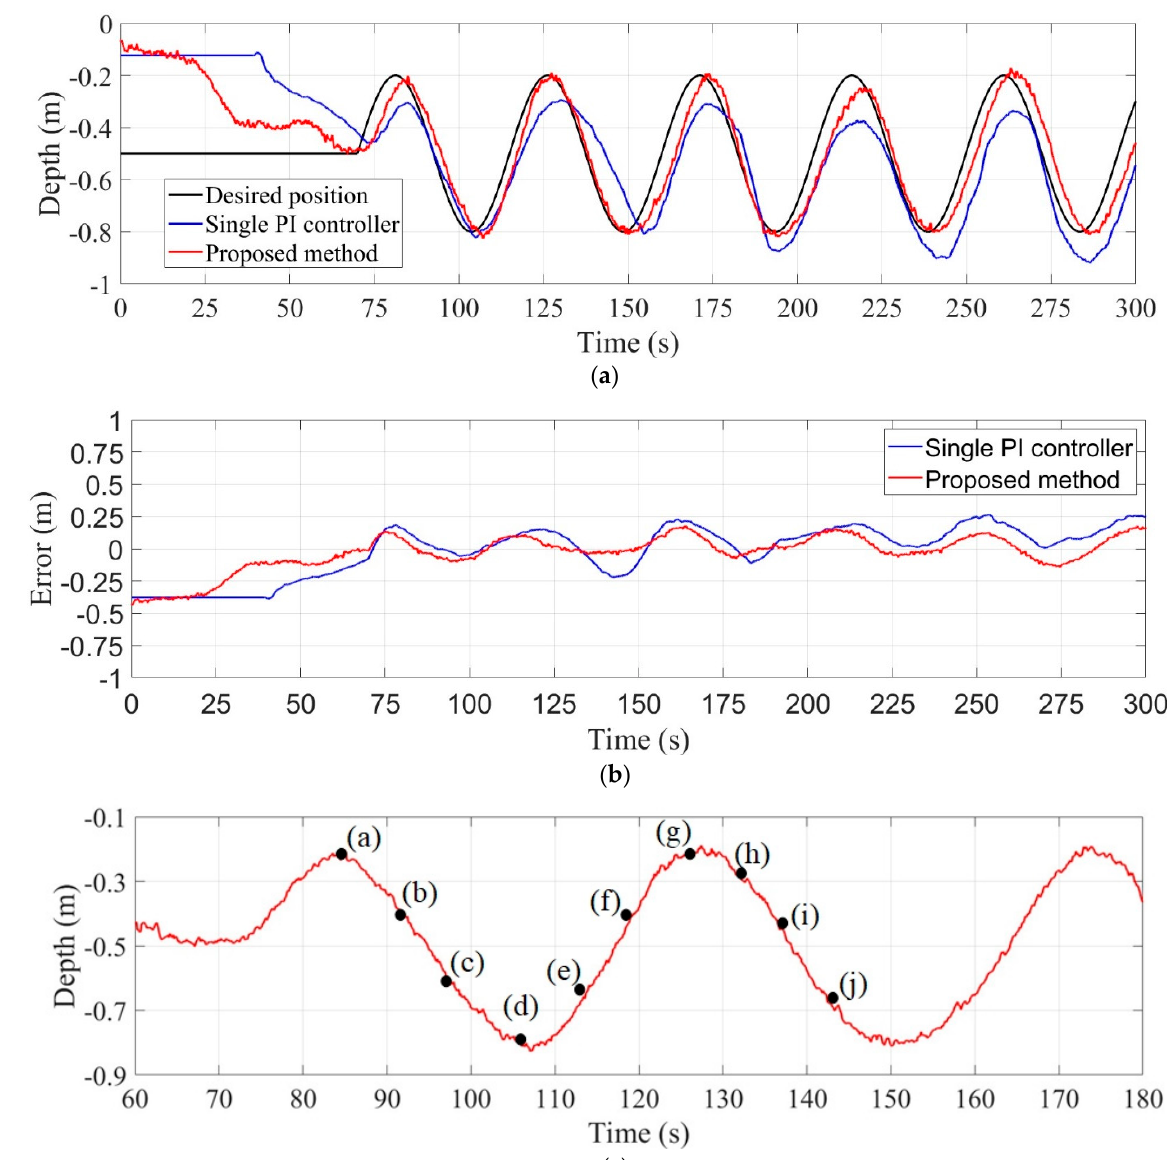
Figure 12. Sine-wave heaving experiment. ( a ) Start diving at the depth of − 0.2 m. ( b ) Dive-down to − 0.4 m. ( c ) Dive-down to − 0.6 m. ( d ) Dive-down to − 0.8 m. ( e ) Float-up to − 0.6 m. ( f ) Float-up to − 0.4m. ( g ) Float-up to − 0.2 m. ( h ) Dive-down to − 3 m. ( i ) Dive-down to − 0.45 m. ( j ) Dive-down to − 0.65 m.